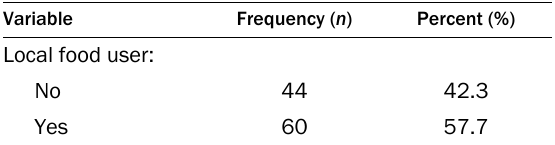
Table 4. Current Local Food Users ( n